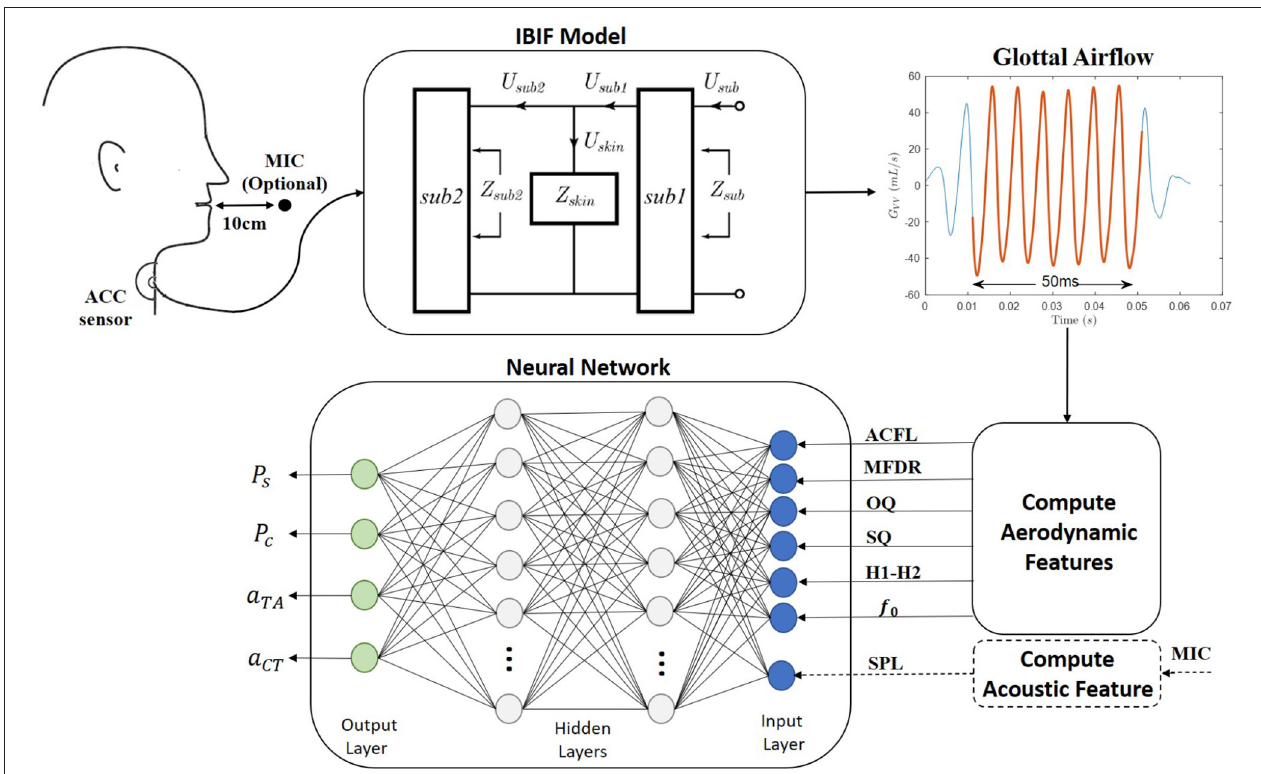
FIGURE 1 | A schematic of the proposed method for the ambulatory vocal assessment based on processing the neck skin acceleration signal and a regression neural network.